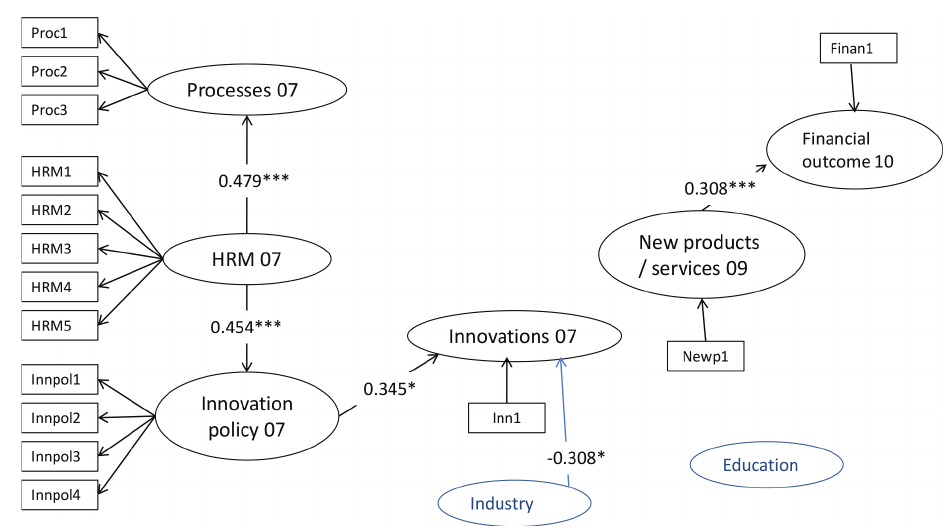
Fig. 3. Results of the estimated model